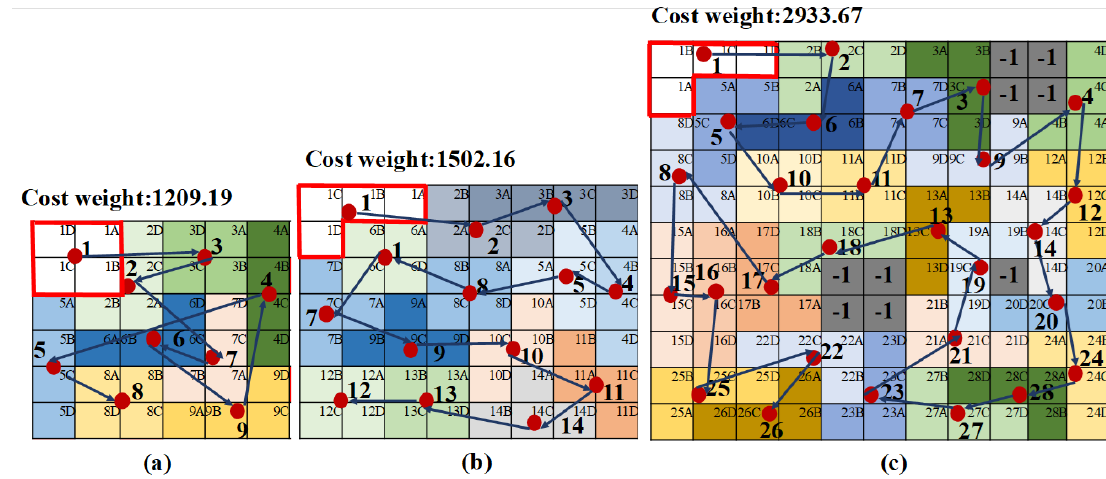
Figure 13. Optimal trajectories with associated cost weights for workspaces. ( a ) optimal trajectory for 6 × 6, ( b ) optimal trajectory for 8 × 7, ( c ) Optimal trajectory for 11 ×